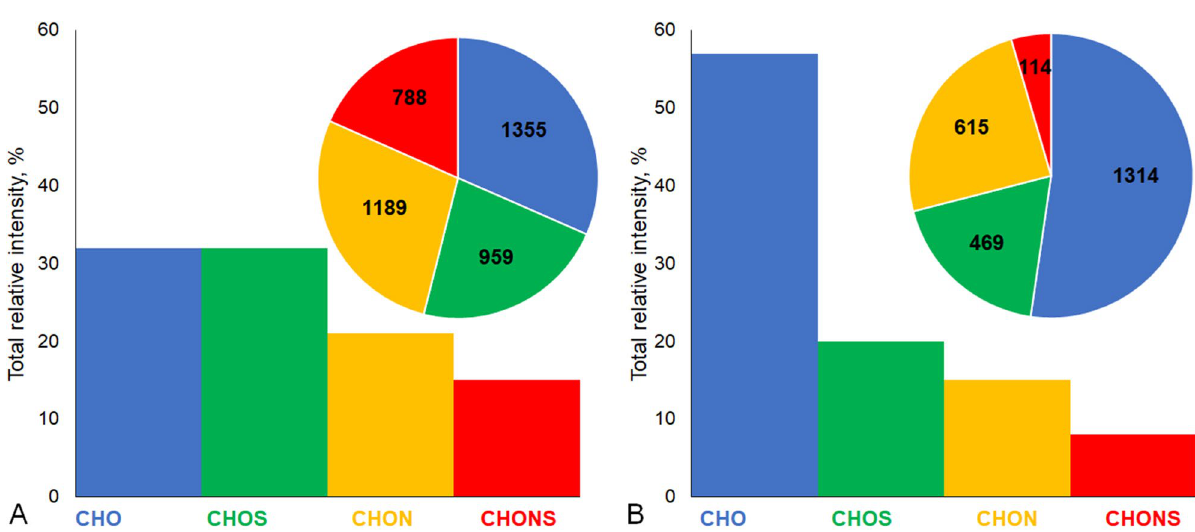
Figure 5. Distribution of different molecular compositions determined from the FTICR MS data assignments: ( A , B) —summarized relative intensity and a number of formulae for alkali-extracted IOM from Murchison and Allende,